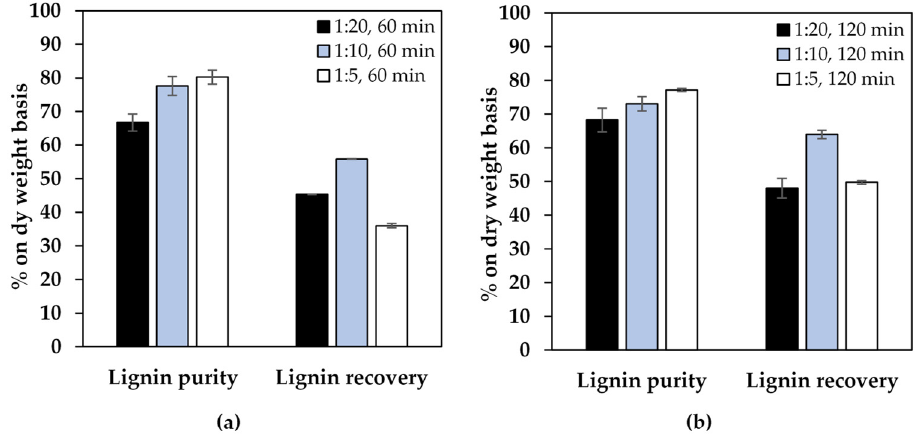
Figure 3. E ff ect of solid to liquid ratio and retention time of ( a ) 60 min and ( b ) 120 min (pretreatment at 210 ◦ C) on lignin purity ( p -value = 0.009 and p -value = 0, respectively) and recovery ( p -value = 0 and Figure 3. Effect of solid to liquid ratio and retention time of (a) 60 min and (b) 120 min (pretreatment 258 p -value = 0.002, respectively). Error bars represent ± 2 × the standard at 210 °C) on lignin purity ( p- value = 0.009 and p- value = 0, respectively) and recovery ( p- value = 0 259 and p- value = 0.002, respectively). Error bars represent ± 2× the standard deviation. 260